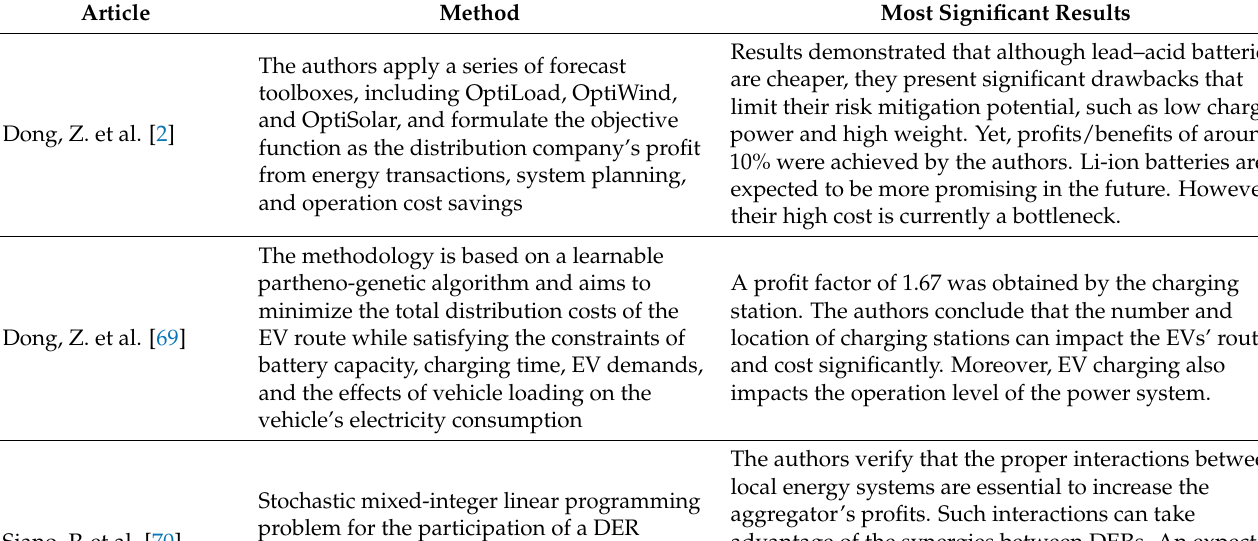
Table A6. Methods and most significant results of the papers assessed more